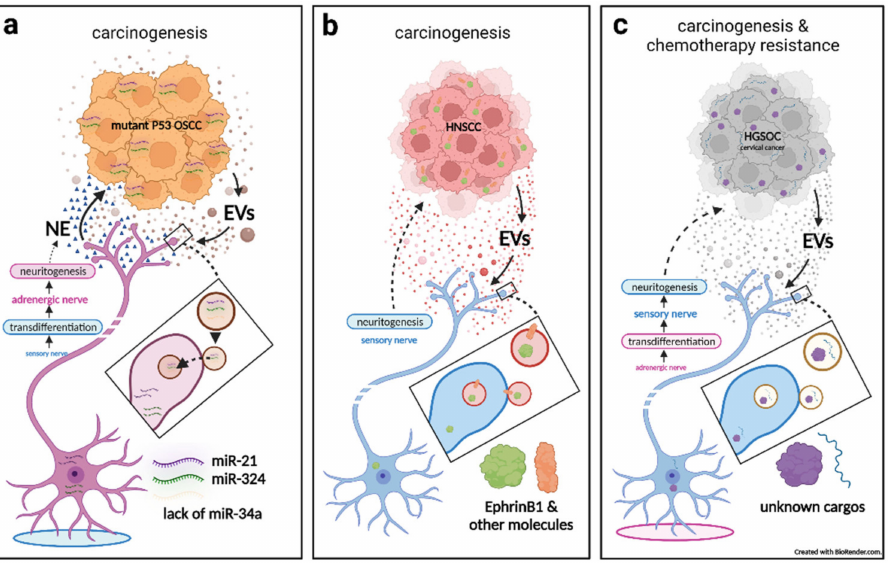
Figure 2. The three roles of extracellular vesicles (EVs) in cancer–nerve crosstalk are: ( a ) cancerous EV- delivered miRNAs (a combination of increasing miR-21, miR-324, and a lack of miR-34a) induce nerve reprogramming and neuritogenesis, which facilitates tumorigenesis; ( b ) cancerous EV-delivered axon guidance proteins (EphrinB1) promote sensory nerve neuritogenesis, which facilitates tumorigenesis; and ( c ) sensory neuritogenesis promotion by cancer EVs facilitates tumorigenesis, tumor-associated pain, and chemotherapeutic resistance. OSCC: oral squamous cell carcinoma: EV: extracellular vesicle; NE: noradrenaline; HNSCC: head and neck squamous cell carcinoma; HGSOC: high-grade serous ovarian